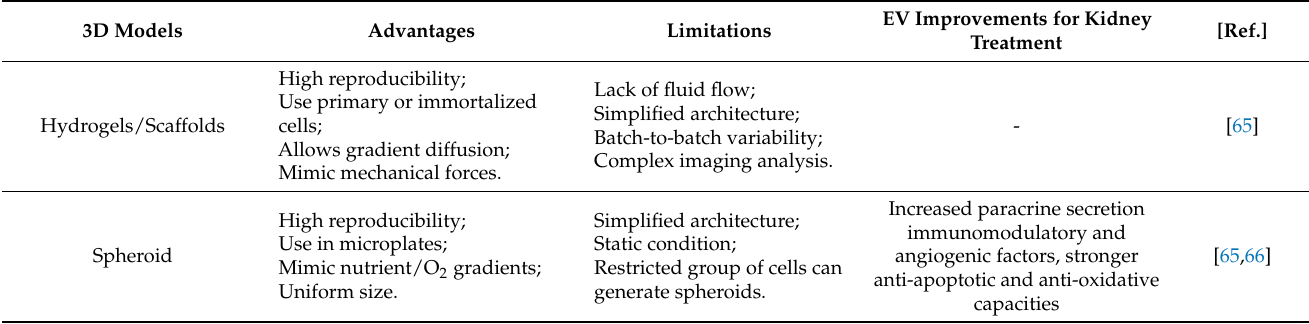
Table 2. 3D models and EV therapeutic improvements in the